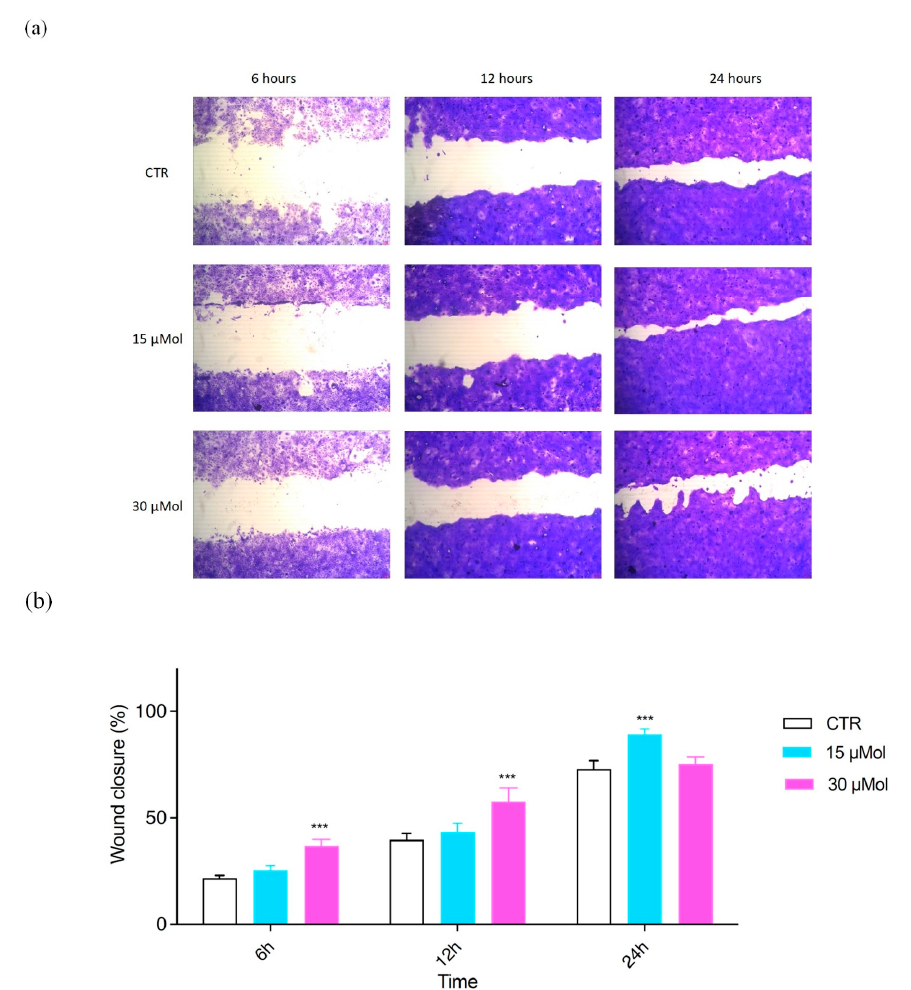
Figure 5. ( a ) Representative images of the wound field observed at 6, 12, and 24 h for untreated cells (CTR) and for cells treated with RS+MO-07 (15 and 30 µ Mol). ( b ) Histogram plot together with ± SD